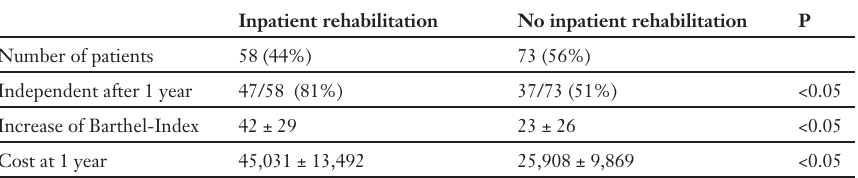
The outcome data of the patients with in- patient rehabilitation are compared with those without. Note the increase of the Barthel-index and the percentage of pa- tients at the nursing home; 81% of the pa- tients with inpatient rehabilitation were independent at home after 1